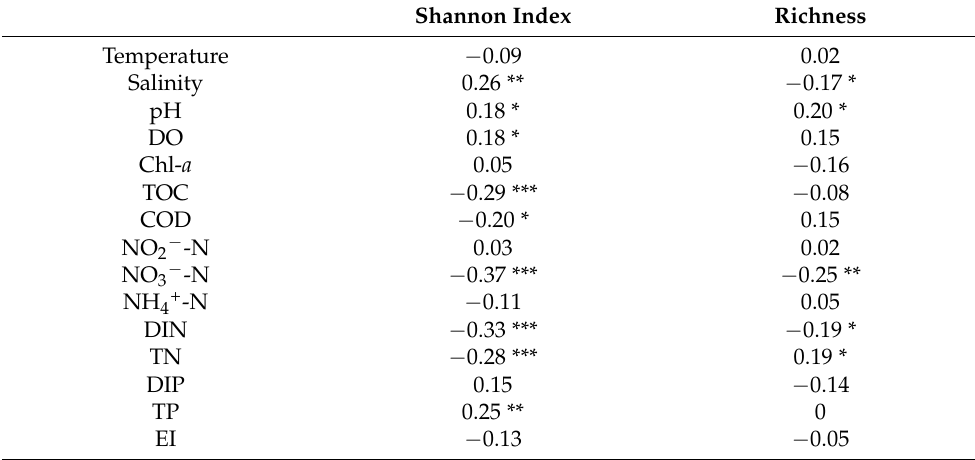
Table 1. Correlations between the Shannon α-diversity index and environmental factors.